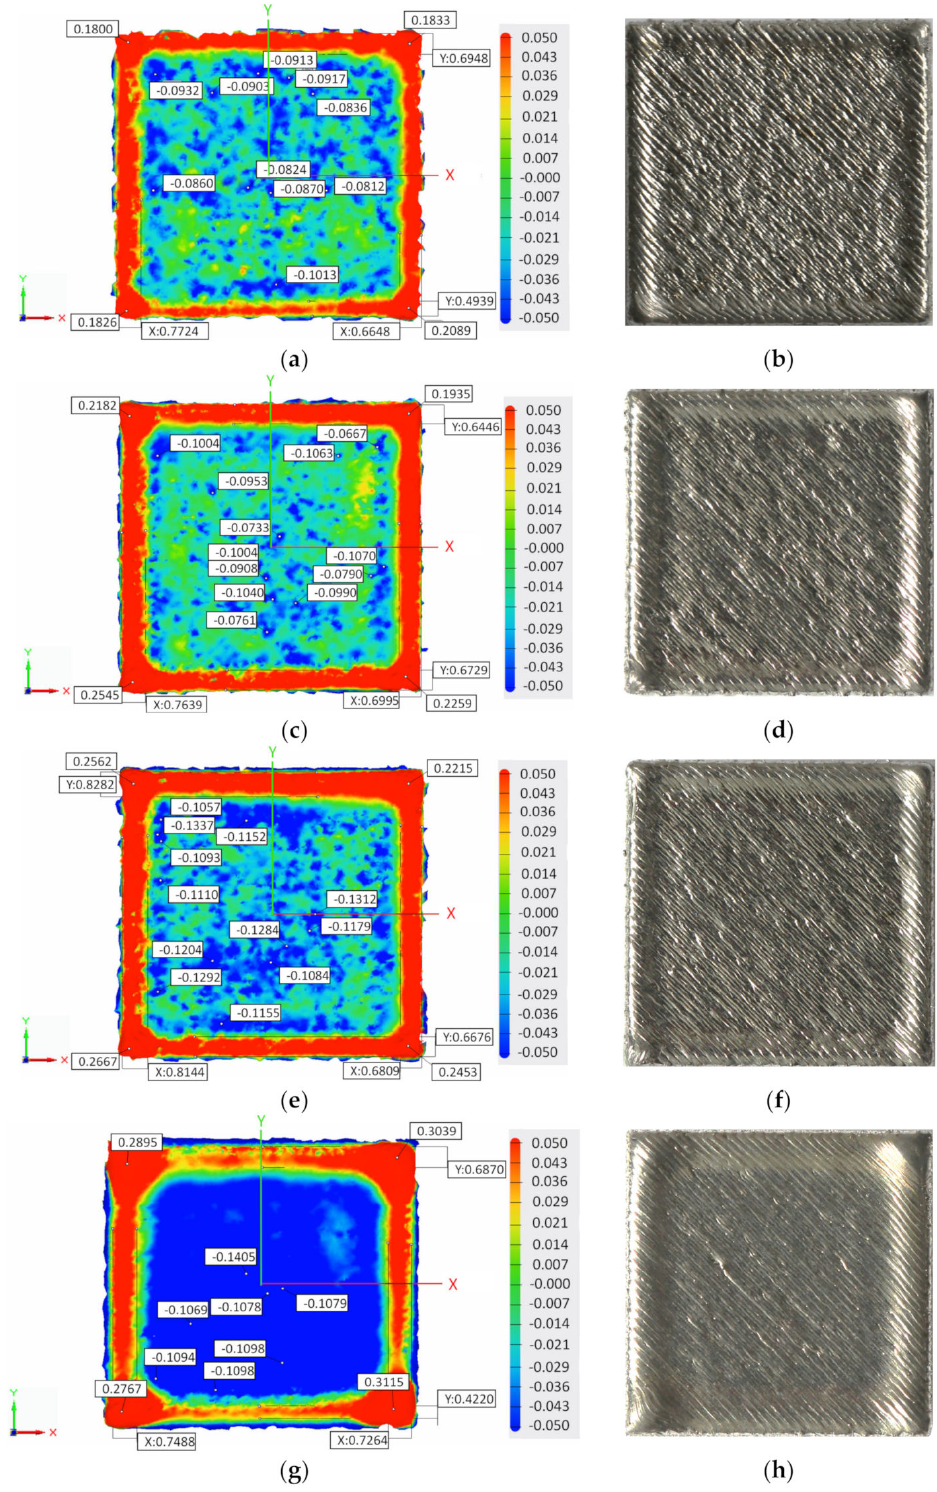
Figure 6. Topography and macroscopic top surface views of the last layer of samples built with a 45 ◦ hatch angle rotation: ( a , b ) without remelting—reference, ( c , d ) with one remelting pass, ( e , f ) with two remelting passes, and ( g , h ) with three remelting